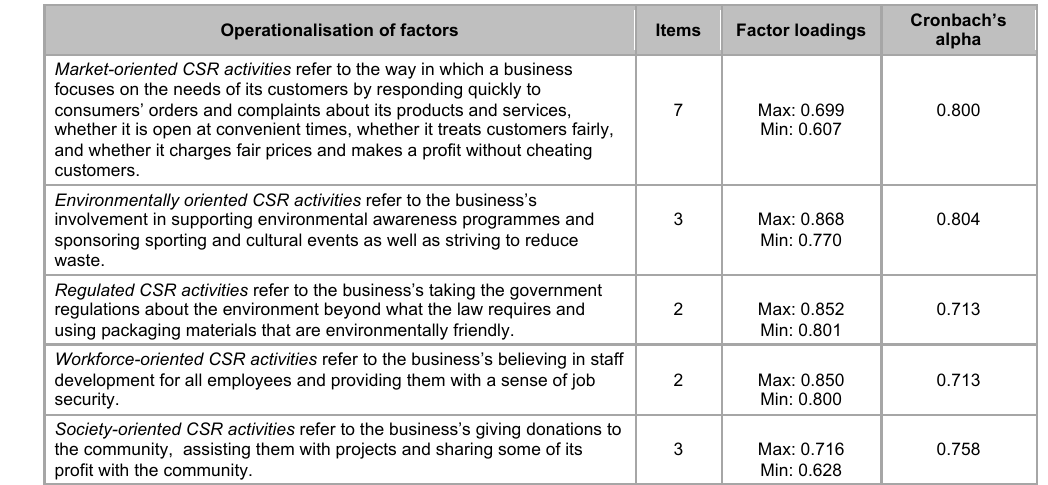
Measurement instrument